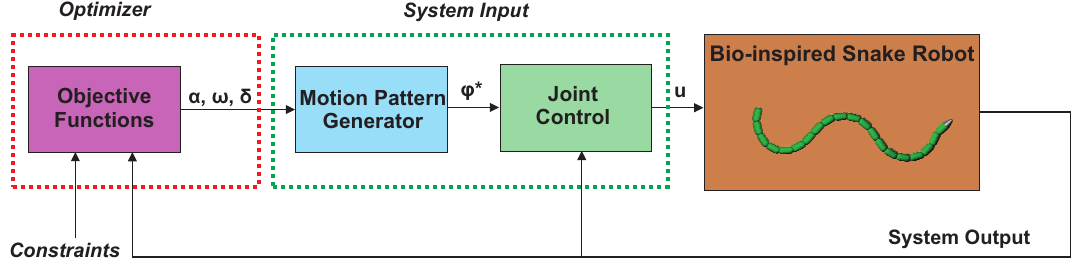
Figure 3. Illustration of the optimization